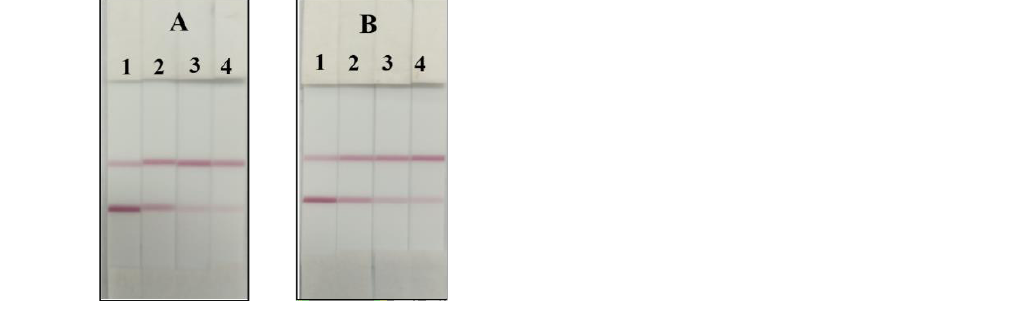
Figure 10. The sensitive analysis of the endosulfan colloidal gold ICA strip. ( A ) Pear: 0, 20, 40, 80 ng/g; ( B ) apple: 0, 20, 40, 80 ng/g.